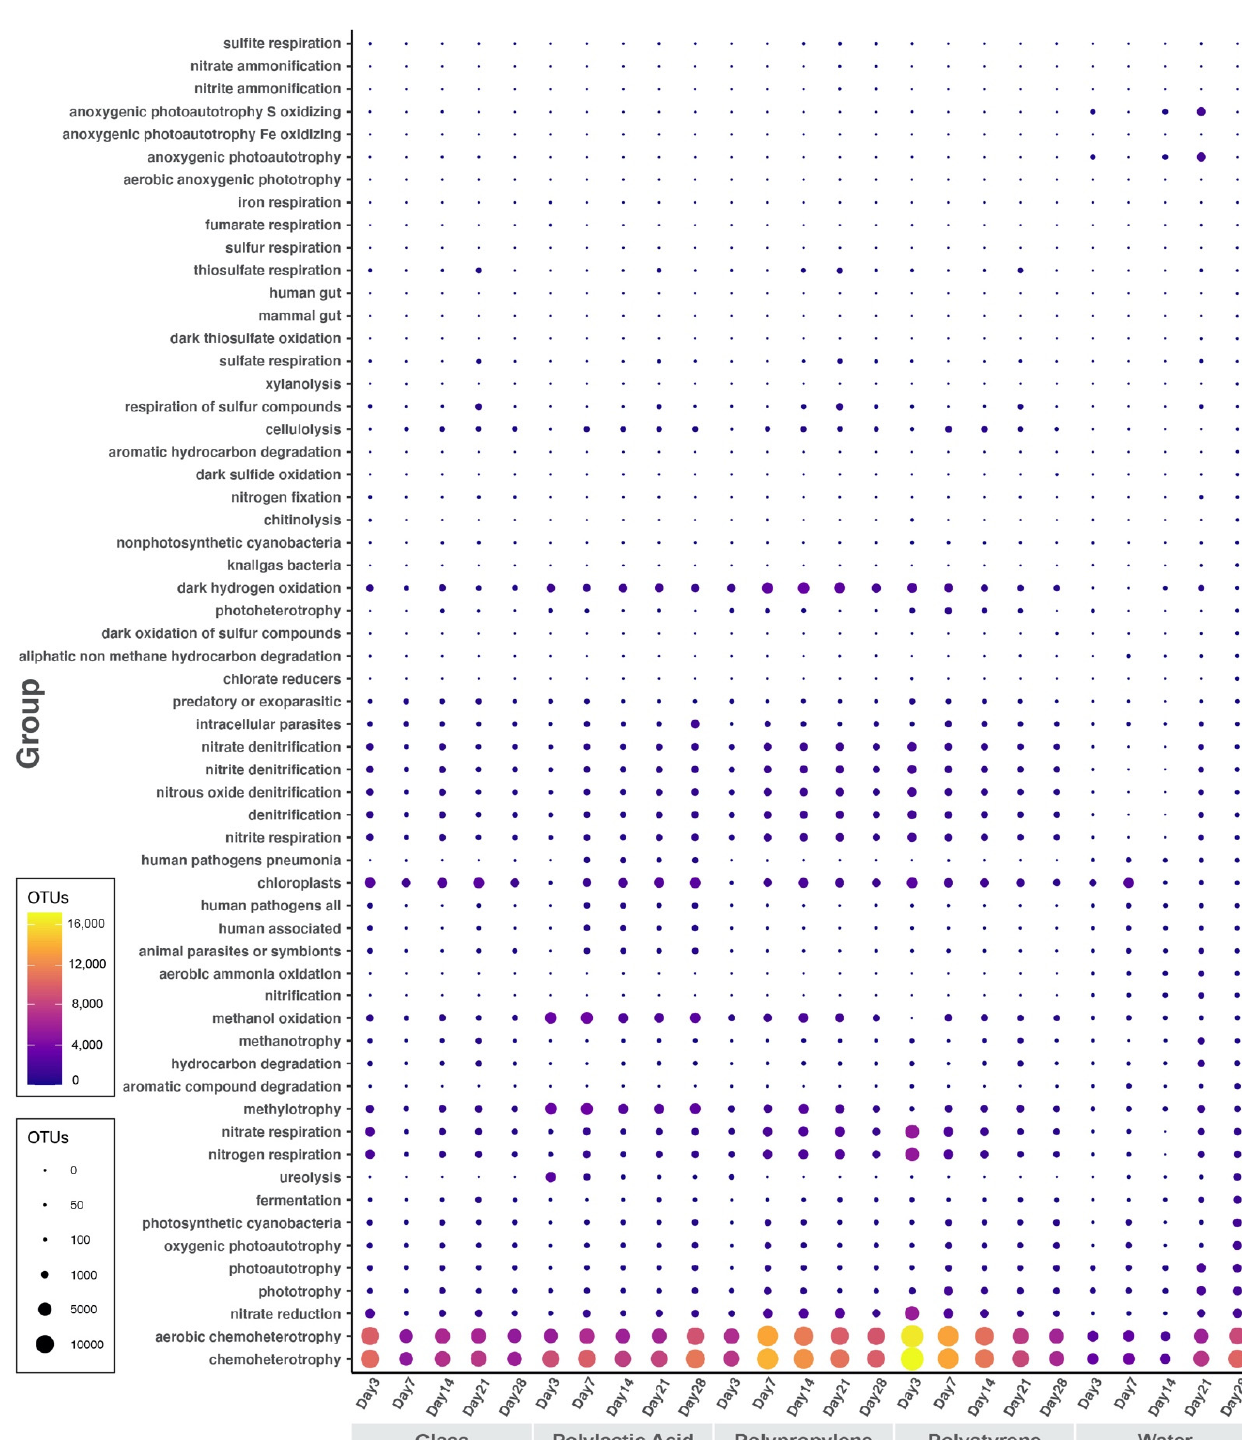
Figure 6. Ecologically relevant function abundance per sample. Bubbles represent the number of OTUs that have been classified by FAPROTAX as a functional group in each sample.